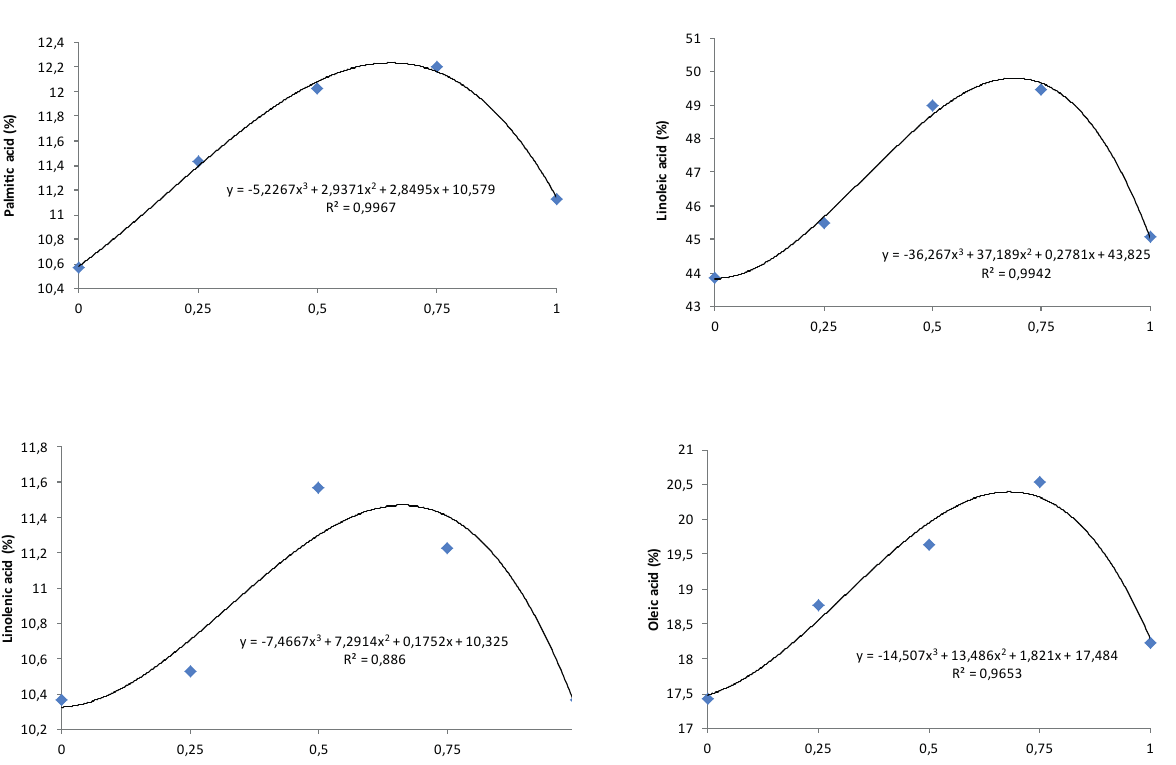
(Table IV). The effect of nano-Fe on amount of iron, magnesium, calcium and phosphorus were significant at 1% of probability level.